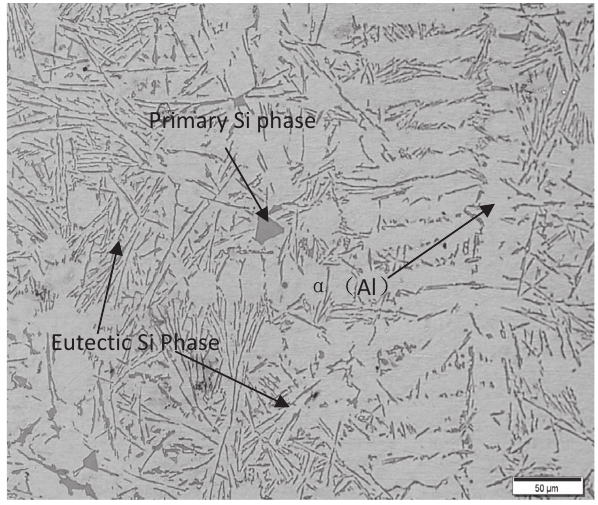
Figure 1: Optical image of initial hypoeutectic Al – 10Si alloy.